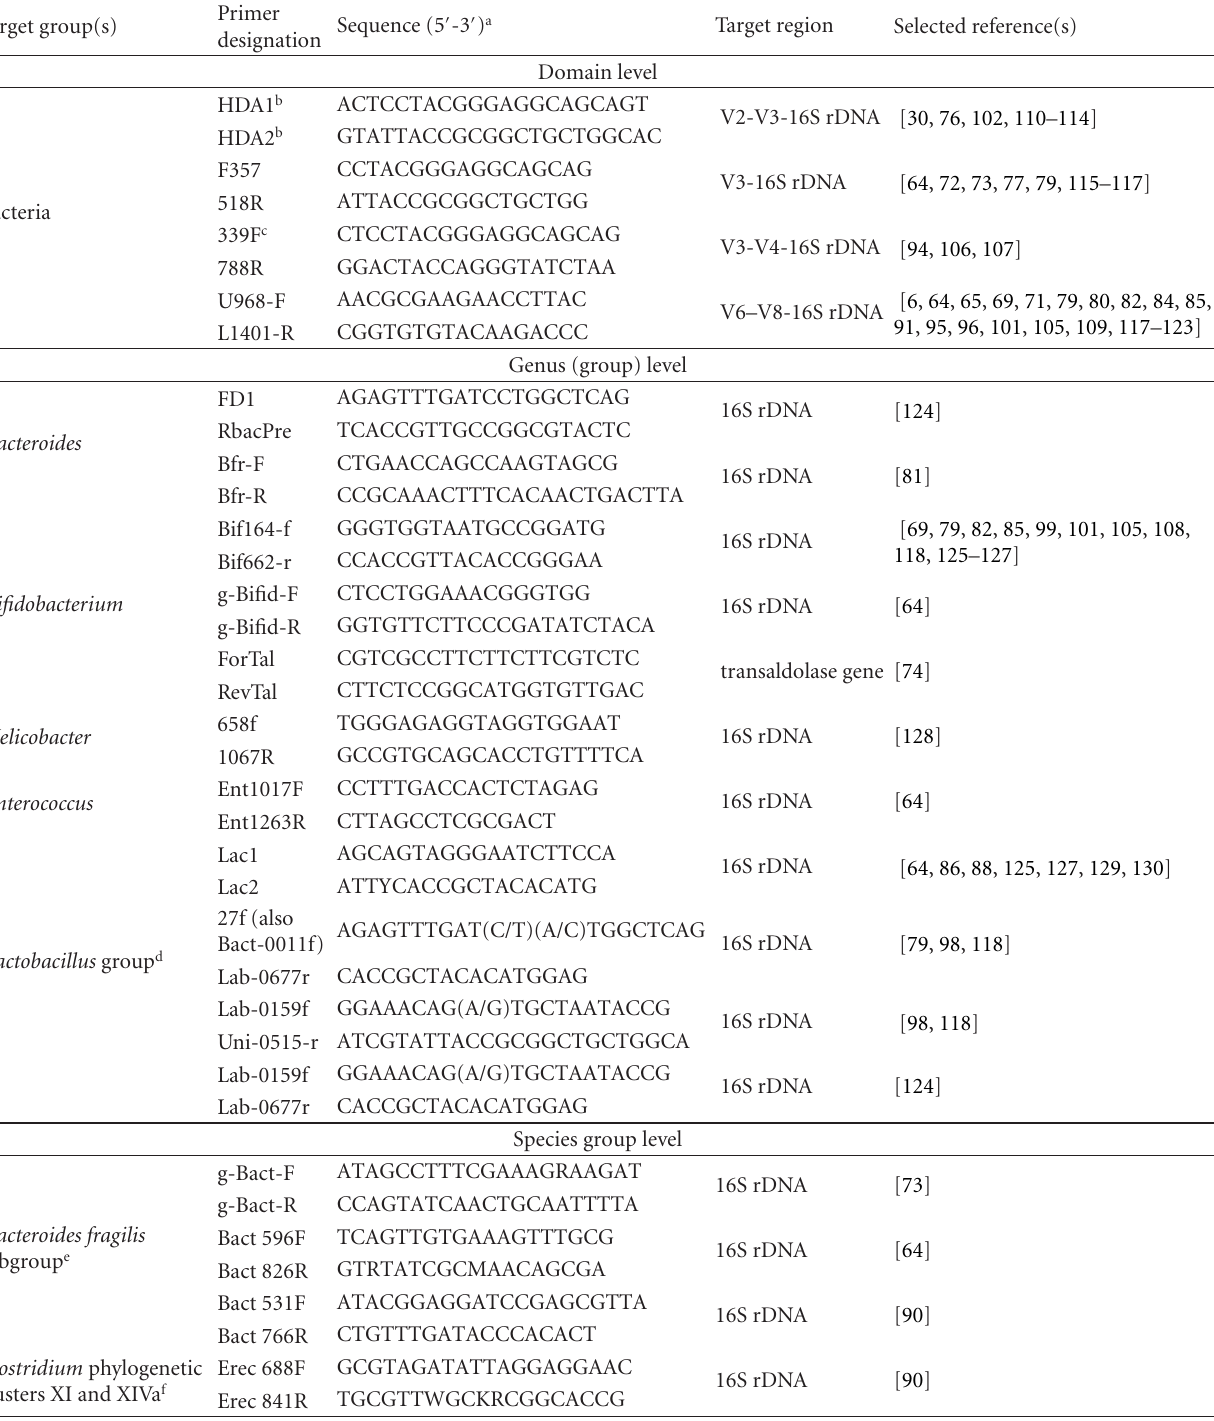
Table 2: Universal and group-specific PCR primers used in SDE-based profiling of human intestinal microbial